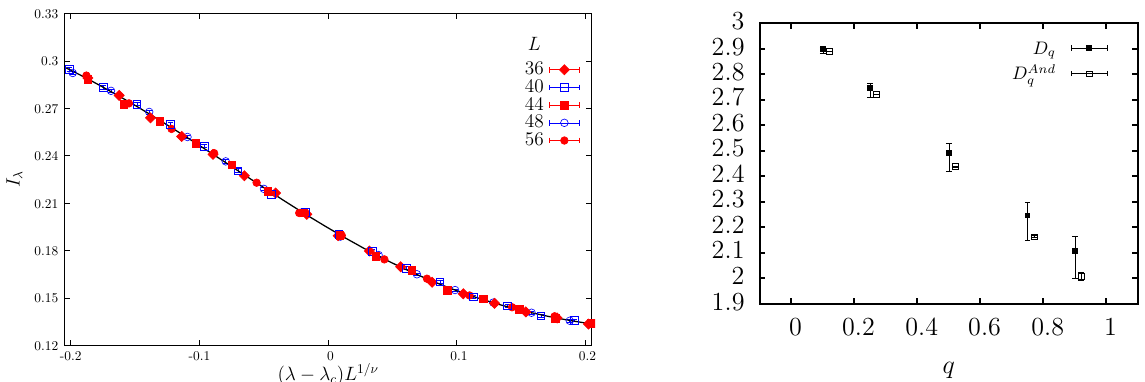
Figure 10. Left : scaling of I s near the mobility edge in 2+1 QCD with staggered quarks, at T = 394MeV and a = 0.125fm. 0 The linear size L of the lattice is expressed in lattice units. Here λ c 0.3364, ν 1.43, and the critical value is I s 0 0.194. (cid:39) (cid:39) | λ c (cid:39) From Ref. [34]. (Reprinted figure with permission from M. Giordano, T.G. Kovács and F. Pittler, Phys. Rev. Lett. 112, 102002 (2014). Copyright (2014) by the American Physical Society). Right : multifractal exponents D q , governing the scaling of L − D q ( q − 1 ) at large linear size L at the mobility edge, in 2+1 QCD with staggered quarks ( T = 394MeV, a = 0.125fm) IPR q ∼ and in the 3d unitary Anderson model. From Ref. [37]. (Reprinted figure with permission from L. Ujfalusi, M. Giordano, F. Pittler, T.G. Kovács and I. Varga, Phys. Rev. D 92, 094513 (2015). Copyright (2015) by the American Physical